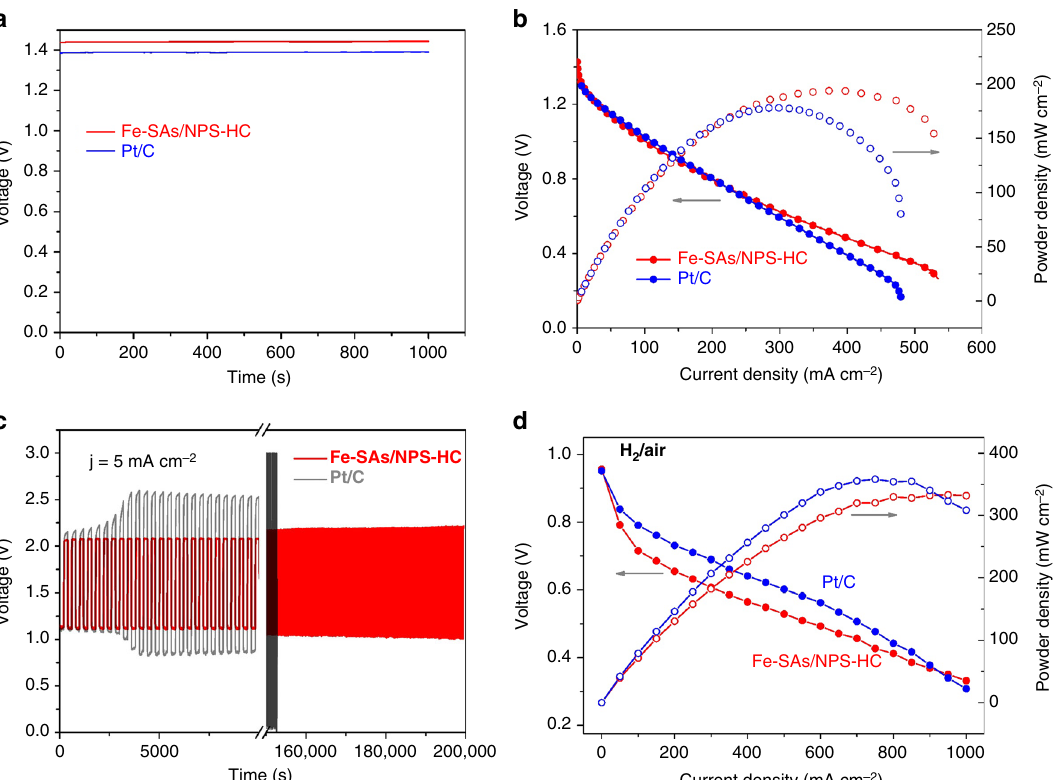
Fig. 6 Zinc-air battery and hydrogen-air fuel cell performances. a The open circuit voltage curves of Zn-air batteries by applying single iron atomic sites supported on a nitrogen, phosphorus and sulfur co-doped hollow carbon polyhedron (Fe-SAs/NPS-HC) and 20 wt% Pt/C as the air cathode catalyst, respectively. b Discharging polarization curves and the corresponding power density plots of Fe-SAs/NPS-HC-based and 20 wt% Pt/C-based Zn-air batteries. c Charge − discharge cycling performance of Fe-SAs/NPS-HC-based and 20 wt% Pt/C-based Zn-air batteries. d H 2 -air fuel cell polarization curves and power density plots of membrane electrode assemblies (MEAs) using Fe-SAs/NPS-HC (loading of 0.8 mg cm − 2 ) and 20 wt% Pt/C (loading of 0.8 mg cm − 2 ) as cathode catalysts, respectively. Membrane Na fi on 211, cell 60 °C, electrode area 5 cm